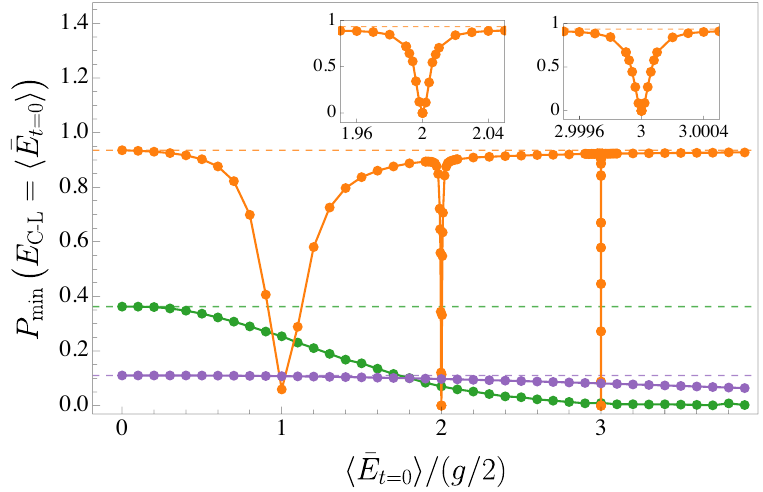
Figure 7. The minimum probability of measuring the dimensionless electric field on the central link to be k/ 2 as a function of the background field at t = 0 for m/g = 50 with mL = 8 (orange), mL = 4 (green), mL = 1 (purple) on an N = 10 lattice. Here we take the total evolution time ( t/a ) = 10 8 and 200 sampling points each simulation for searching the minimum probability. max The dashed lines indicate the invariant probabilities for the trivial ( k = 0 ) quenches: 0 . 93537 for mL = 8 , 0 . 36266 for mL = 4 , and 0 . 11055 for mL = 1 . The dips around integer k in orange demand much longer ( t/a ) than other points to extract. And all other points (i.e. orange points away max